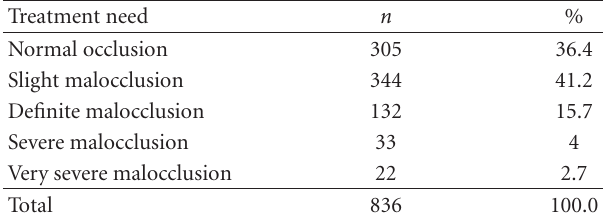
Table 3: Orthodontic treatment need according to TPI scores. Treatment need n % Normal occlusion